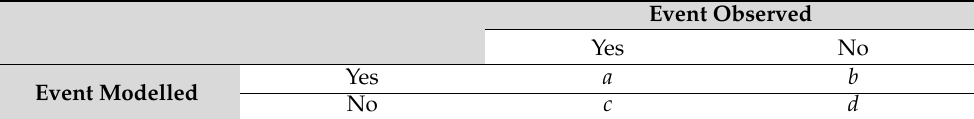
Table 3. Definition of event